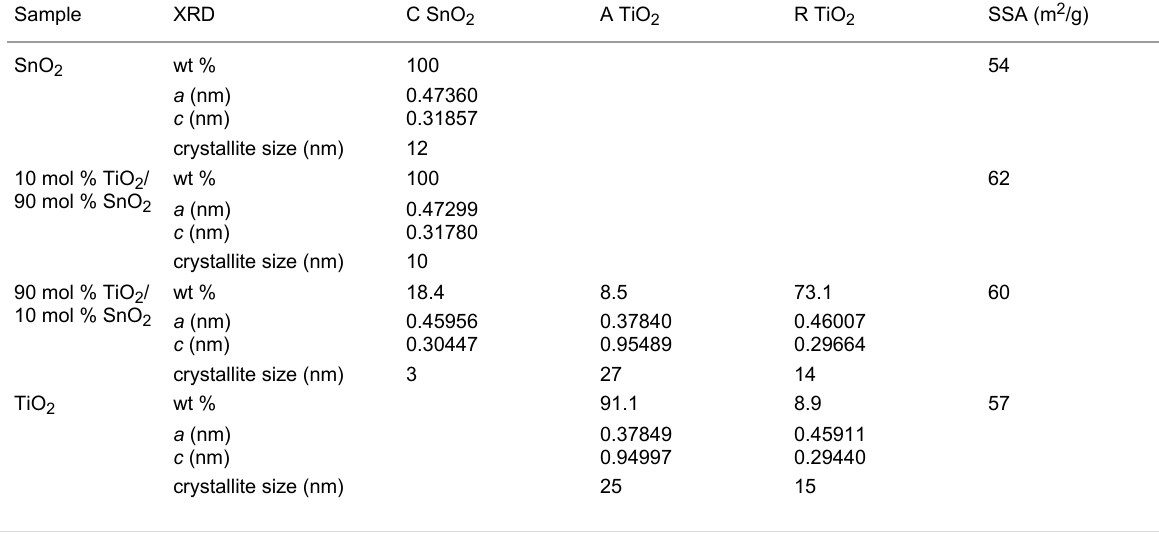
Table 3: The results of BET and XRD Rietveld refinement of TiO 2 –SnO 2 nanomaterials; “A” denotes anatase, “R” rutile and “C” cassiterite; SSA: spe- cific surface area.